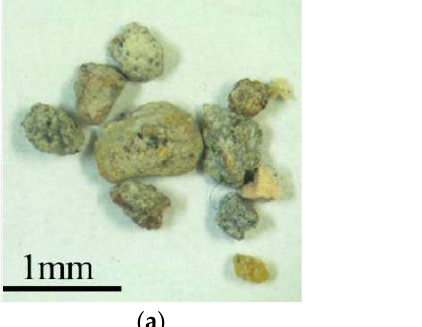
Figure 25. ( a ) Untreated RFA and ( b ) modified RFA [50]. Reproduced with permission from [50], Elsevier, 2020.